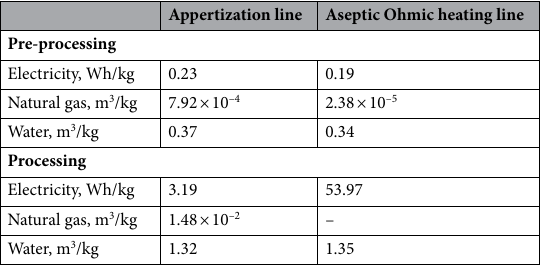
Table 2. Overview of energy and water consumption for producing 1 kg of CTwJ through industrial appertization and aseptic ohmic heating lines.